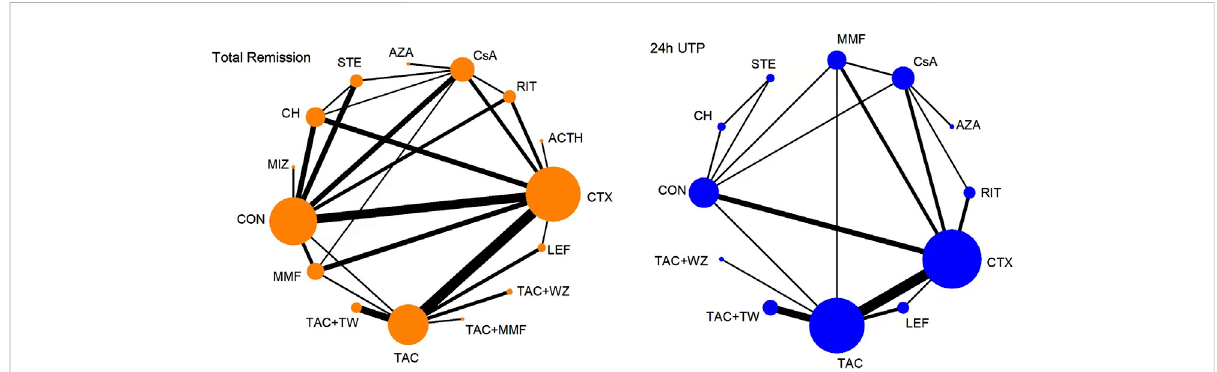
FIGURE 2 Networkmeta-analysisofeligiblecomparisons fortotalremissionand24-hUTP.Thewidthofthelinesrepresentsthenumberofeachpairwise comparison. The size of each node is proportional to the number of randomly assigned participants (ie., sample size). ACTH, adrenocorticotropic hormone; AZA, azathioprine; CH, chlorambucil; CON, non-immunosuppressive therapies (the control group); CsA, cyclosporine;